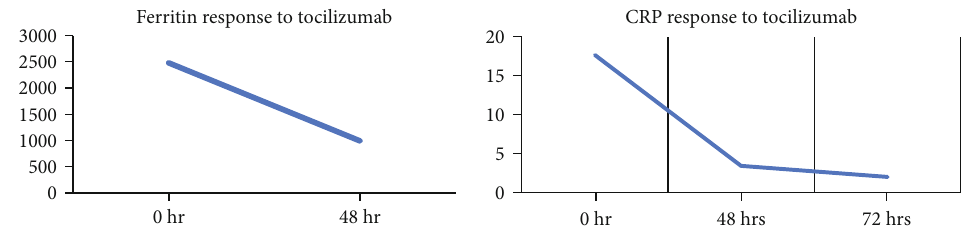
Figure 1: In fl ammatory markers ferritin and CRP were both measured prior to and after the administration of an anti-IL-6 receptor monoclonal antibody. Administration of tocilizumab shows a time-dependent decrease in both ferritin and CRP within 48-72 hours. Baseline ferritin decreased from 2,500 to almost 1,000, whereas baseline CRP decreased from 17 to 2.0. Free kappa and kappa/lambda ratio vs. carfilzomib